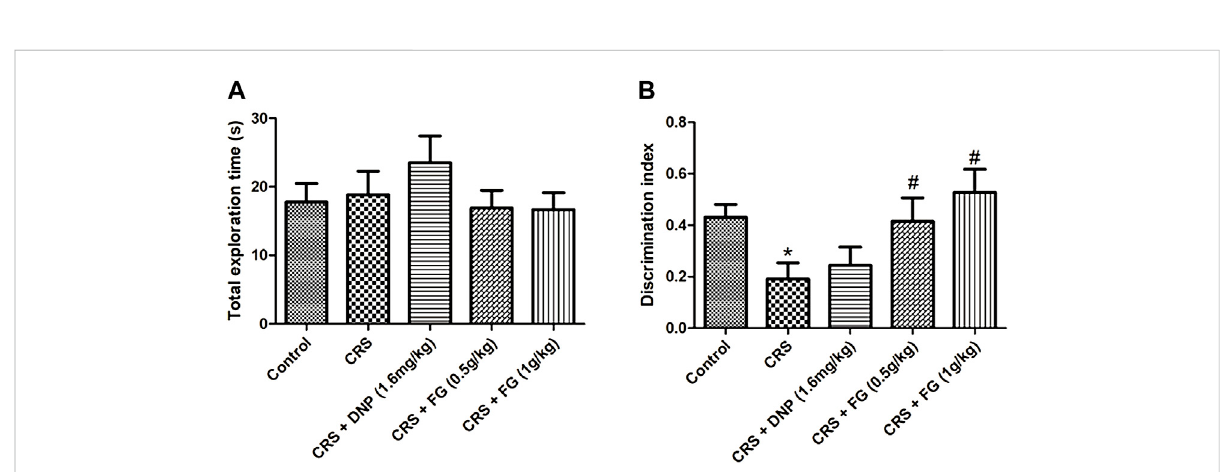
FIGURE 5 Effect ofCRS, FG,and DNPon thenewobject recognitiontestof miceinducedby CRS. (A) Total exploration time infamiliarphase. (B) DIintest phase. Values represent the mean ± S.E.M. n = 8 ~ 12 mice/group. * p < 0.05 compared with the control group; # p < 0.05 compared with the CRS